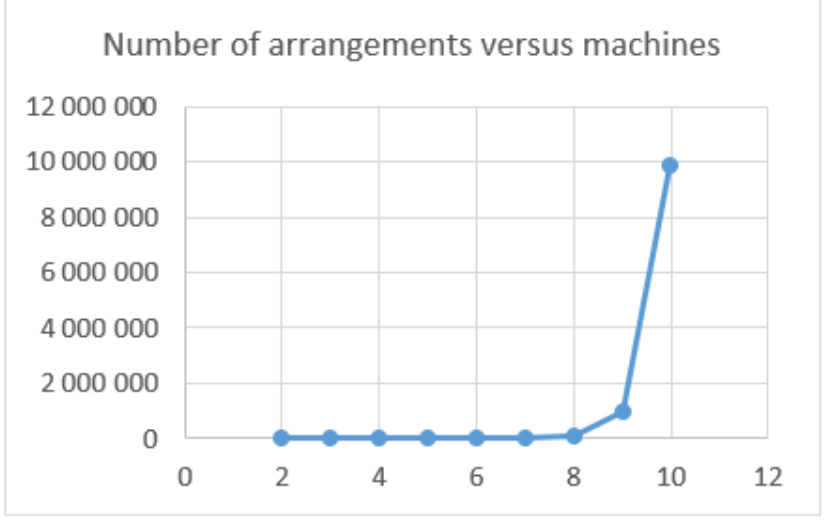
Figure 1. Relation between the number of machines and the number of sets of arrangements of machines to order. machines to